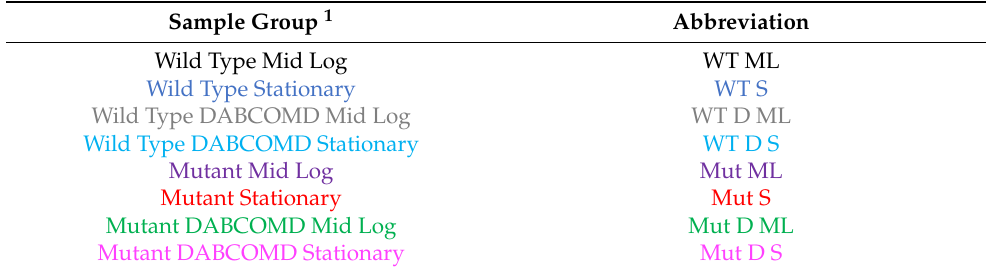
Table 1. Sample sets used in this